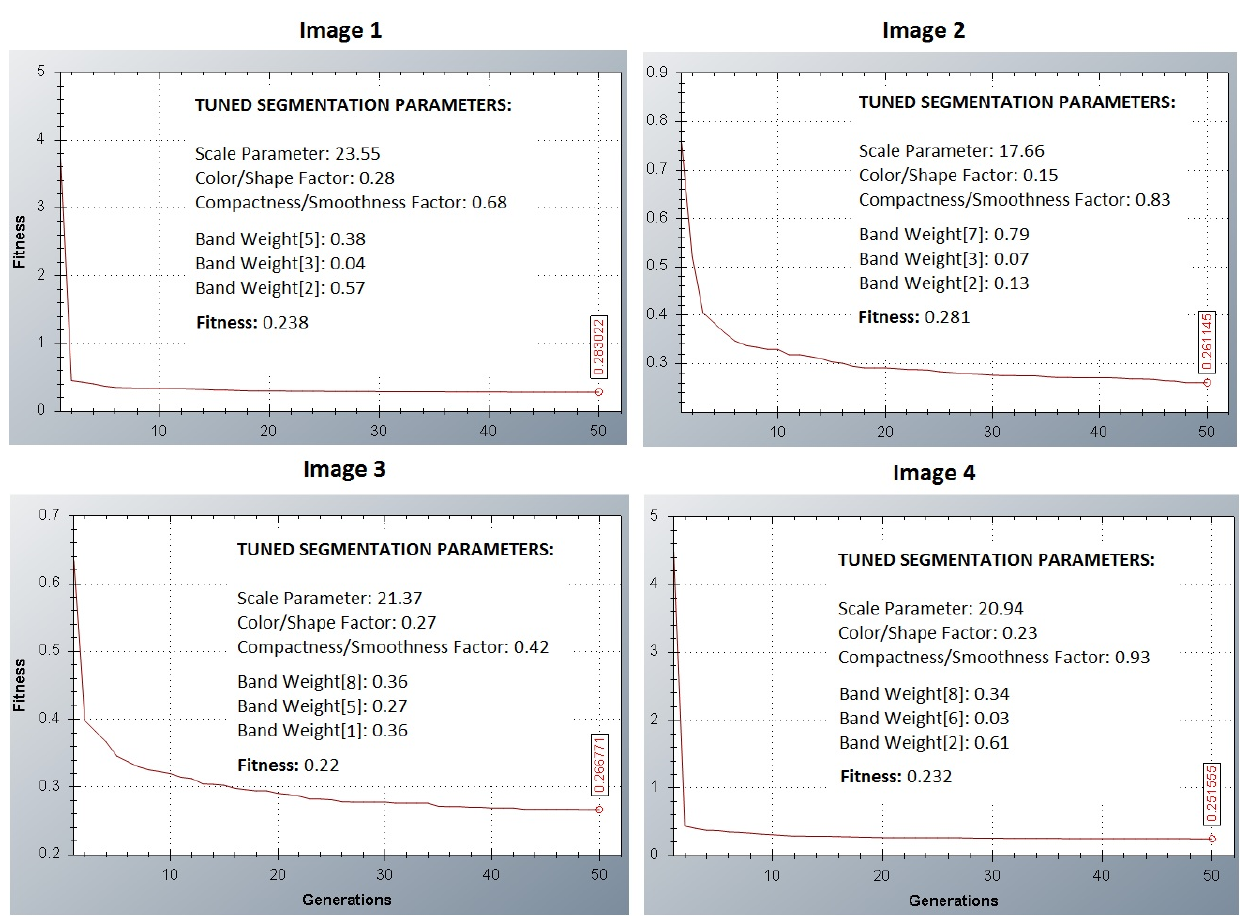
Figure 3. Results obtained with the Segmentation Parameter Tuner